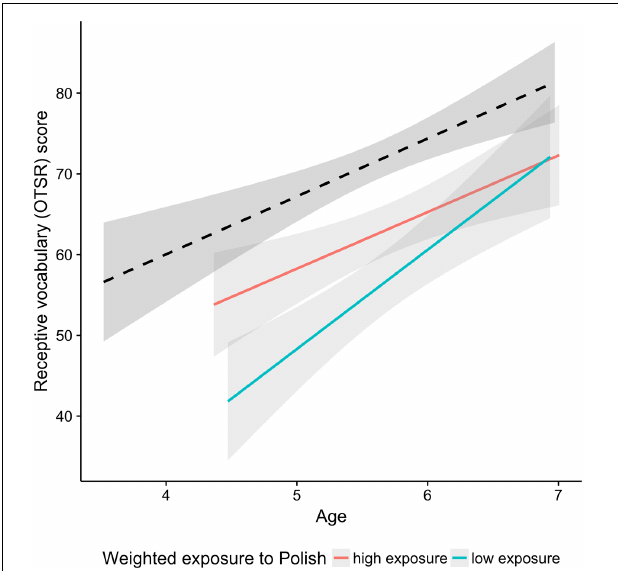
FIGURE 3 | Scores in the receptive vocabulary test plotted as a function of age. The black dashed line indicates the monolingual group and the two colored lines correspond to the bilingual group. Red and aqua correspond to the median split on exposure to L1 Polish. The median split was performed for visualization purpose